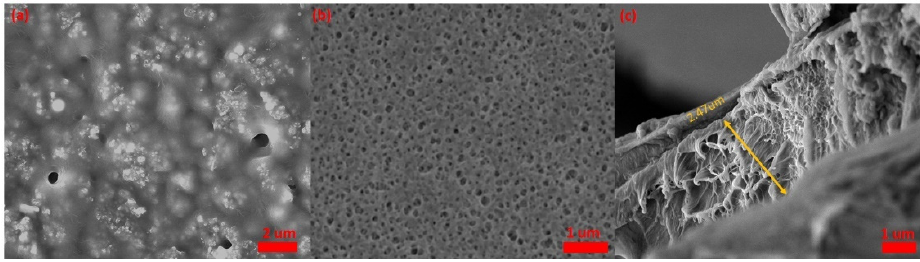
Figure 5. ( a ) SEM image of graphene/PVDF/CAM/DMMP film, ( b ) SEM image of porous graphene/PVDF film, ( c ) thickness of graphene/PVDF sensing film.